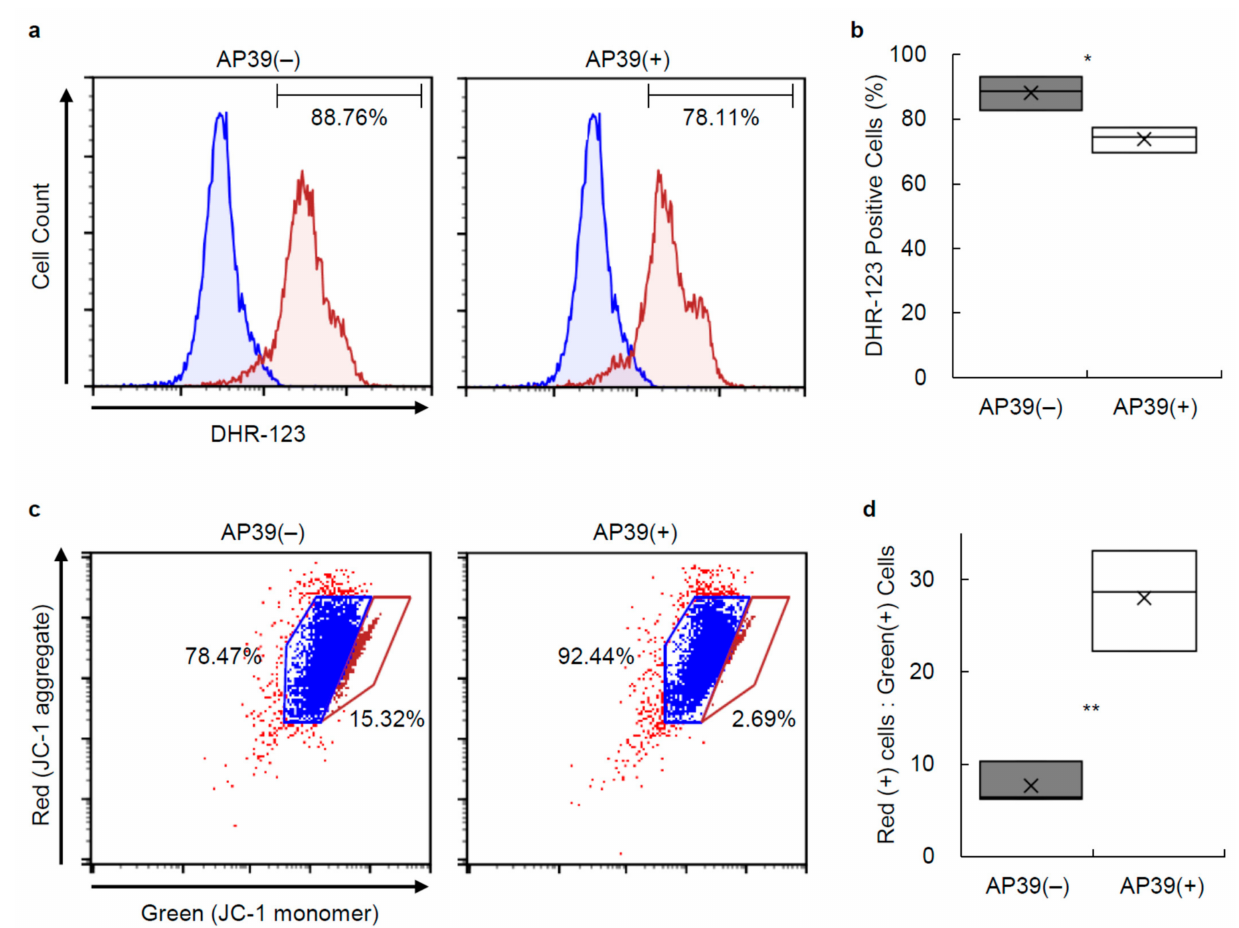
Figure 3. Production level of ROS in cultured islet cells and JC-1 staining of cultured islet cells. ( a , b ) ROS production in 24 h cultured islets with or without AP39 was measured via flow cytometry using staining of dihydrorhodamine-123 (DHR-123). Control cells were not stained with DHR-123. ( a ) Representative plots of DHR-123 fluorescence in dispersed cells. ( b ) Percentage of DHR-123 positive cells. ( c , d ) Mitochondrial membrane potential of 24 h cultured islets with or without AP39 was measured via flow cytometry using JC-1 staining. ( c ) Representative plots of JC-1 staining of dispersed cells. ( d ) Ratio of red (+) to green (+) cells in AP39(+) and AP39( − ) groups. Higher values indicate more cells with polarized (healthy) mitochondria. AP39(+) and AP39( − ) groups: n = 3 each. Data are expressed as the mean ± SE. * p < 0.05. ** p <